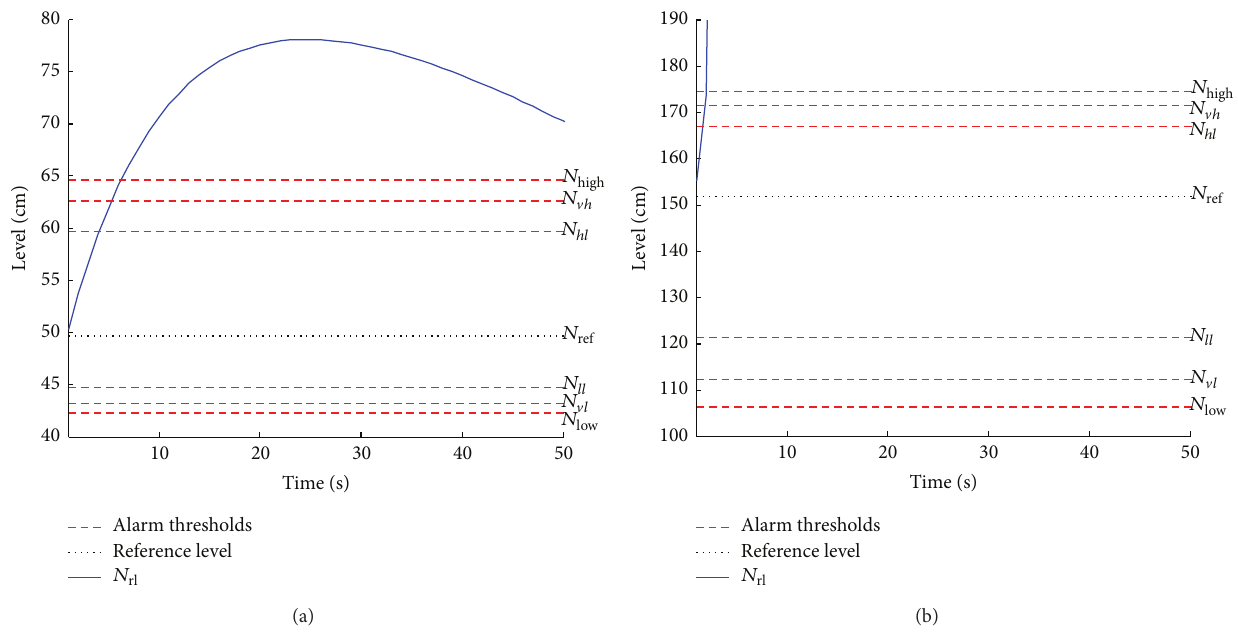
Figure 18: 𝑁 evolution when the steam valve fails stuck at time 𝑡 = 0 at the maximum allowable value of 150% of nominal 𝑄 V that should rl be provided at 5% 𝑃 𝑛 (a) and at 80% 𝑃 𝑛 (b).